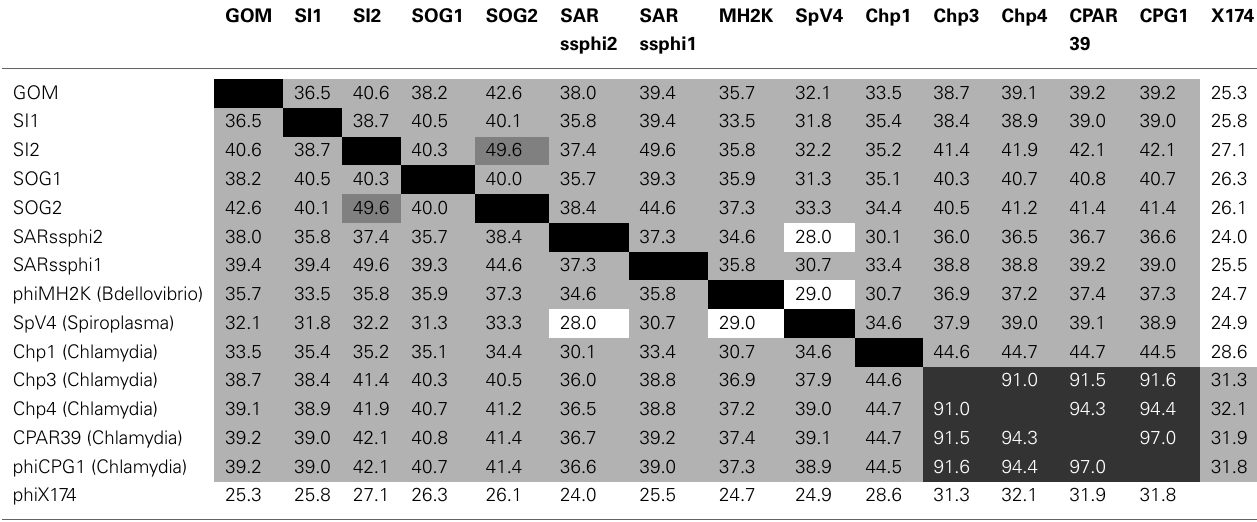
Table 1 | Similarity matrix of the coding regions of the five environmental gokushovirus genomes assembled from this study (bold) with the isolates and other environmental